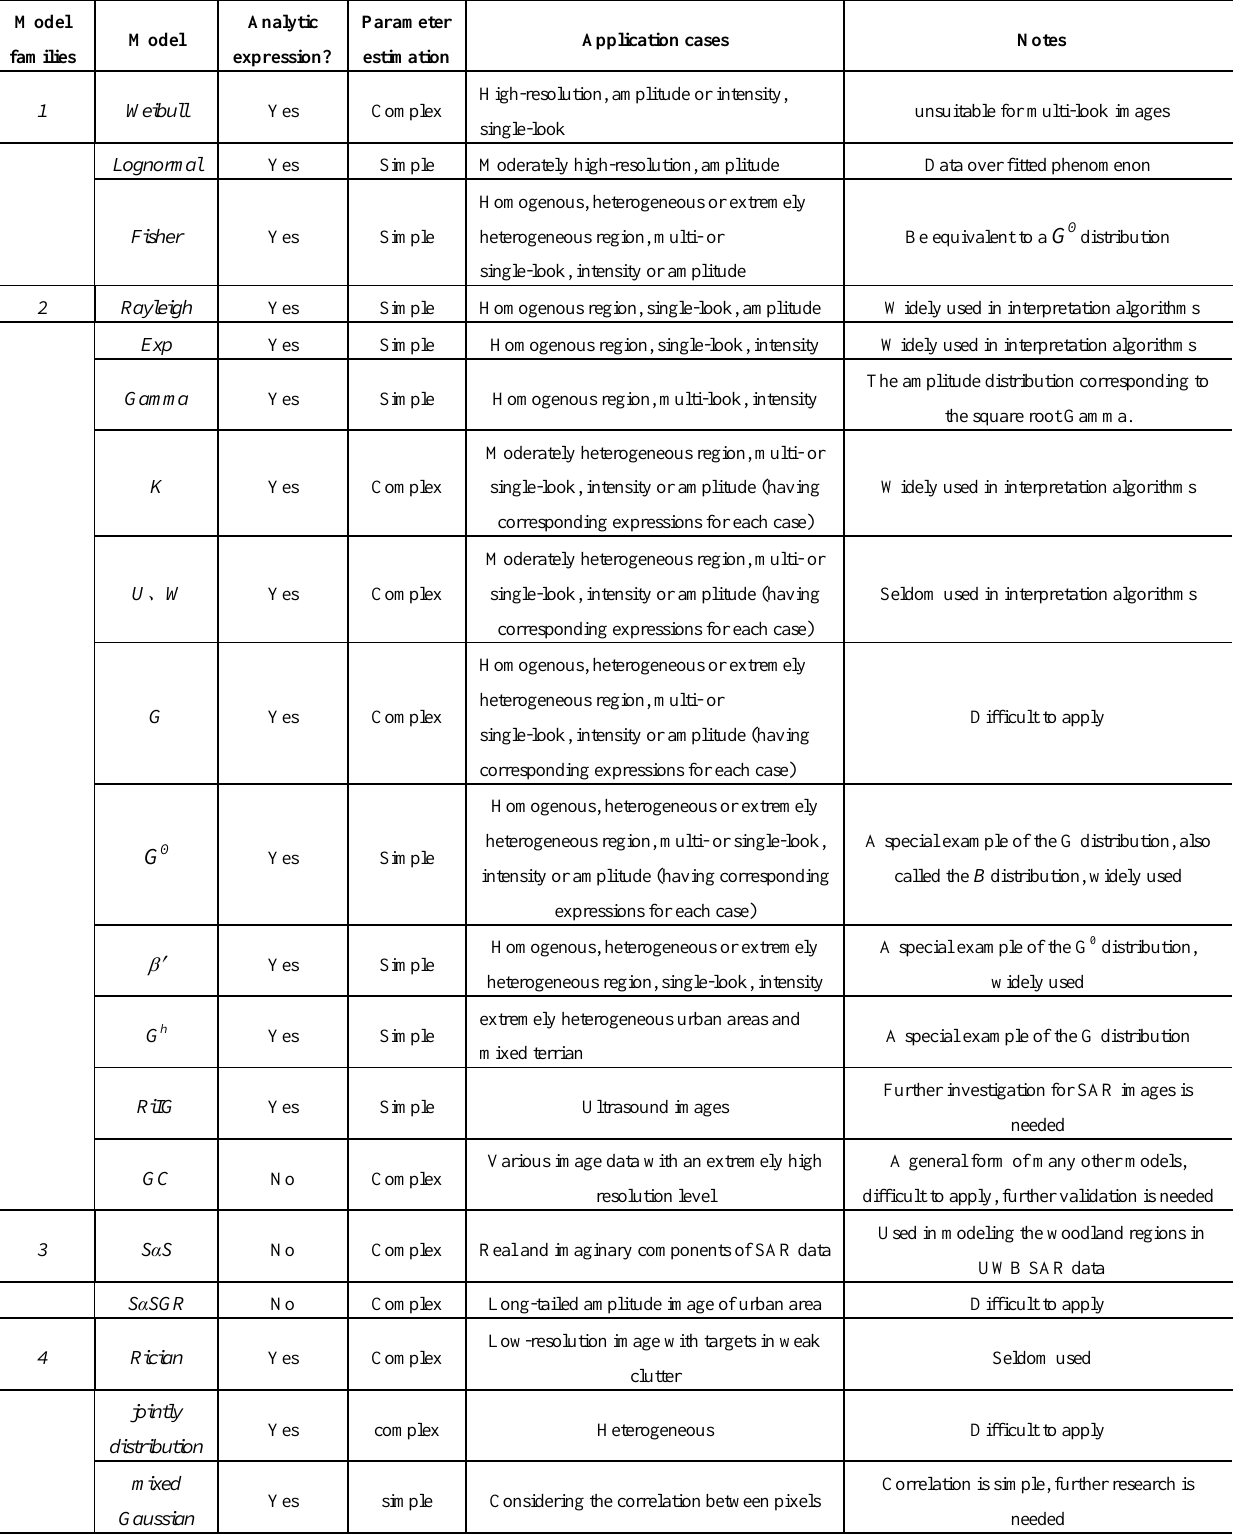
Table 1. Summary of the applications of the major